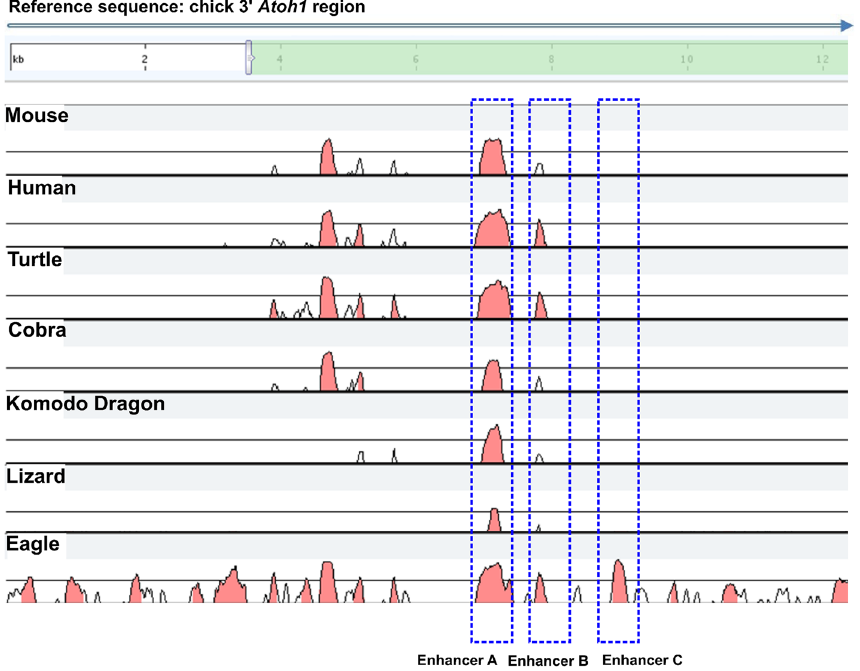
Figure 6. Comparative analysis of the Atoh1 3 ′ sequence in mammalian, avian and non-mammalian non avian species. The comparative alignment was extended to non-avian vertebrate species (Ensembl release 101—August 2020). As shown, the putative enhancer C is not conserved in reptile species but is present in other avian species such as Golden Eagle. A complete analysis of all avian species can be found in Supplementary Data